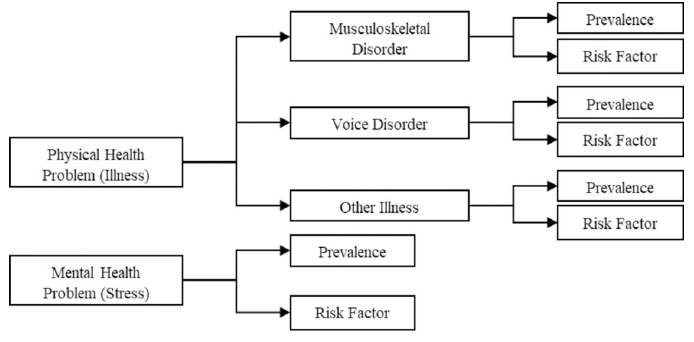
Fig 1. Framework of variables included in the